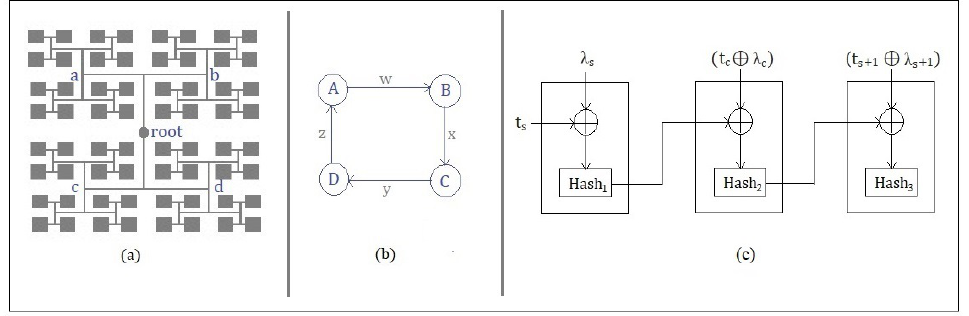
Figure 3. Challenge model. ( a ) Balanced tree with a superfluous sub-branch having 4 × 4 nodes. ( b ) Directed graph transition matrix in each node. ( c ) Hash-chain